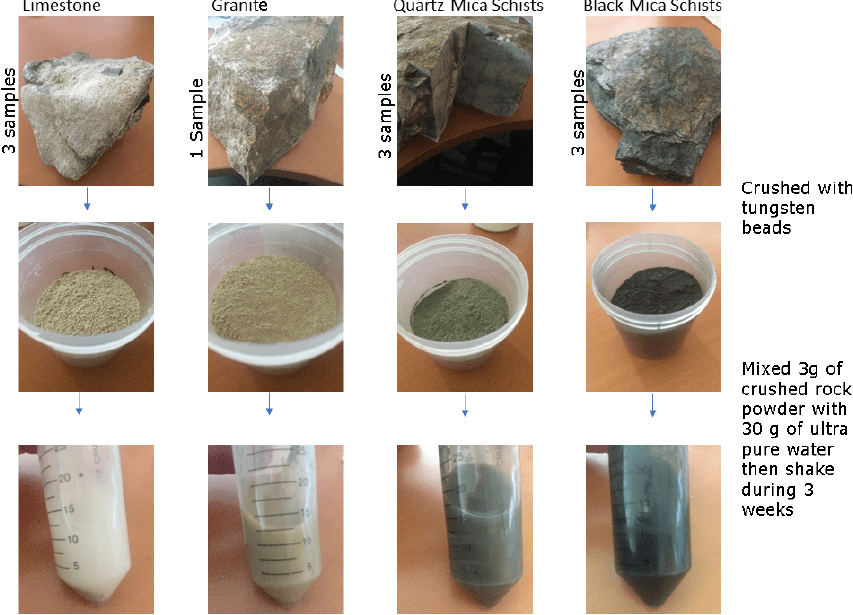
Figure 3. Rock-leaching